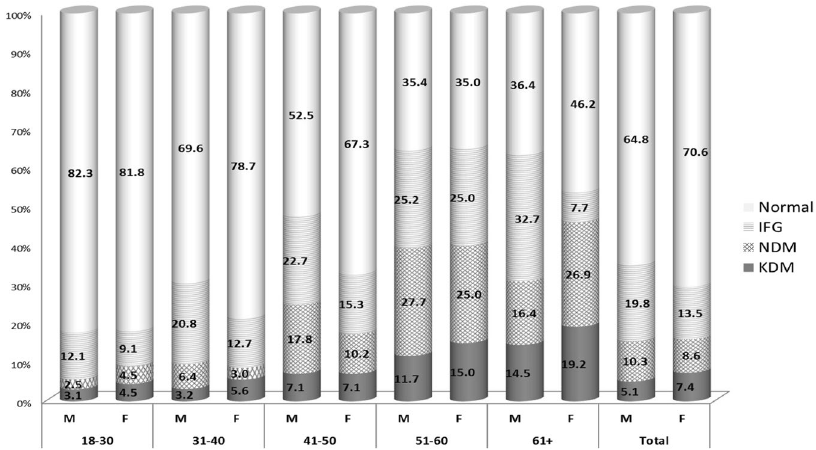
Figure 1. Distribution of Diabetes Status by age and Gender.